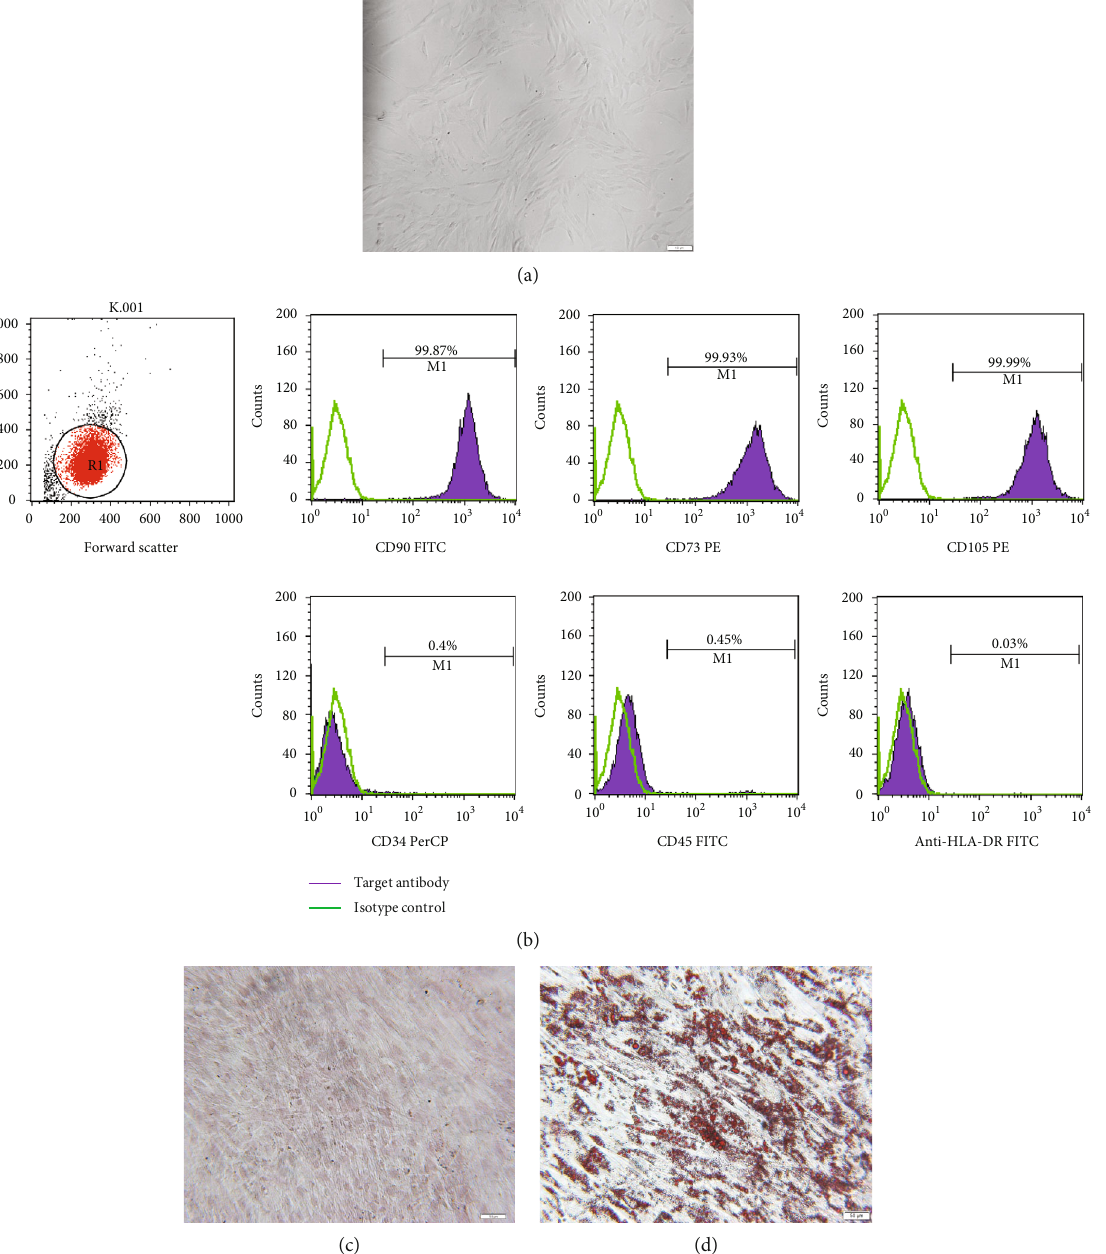
Figure 1: Identi fi cation of human UC-MSCs. (a) Morphological features. The MSCs appeared spindle-like and fi broblastoid-shaped. Scale bar = 100 μ m . (b) Flow cytometric analysis of the expression of cell surface markers related to human UC-MSCs. The expression of each antigen was presented with the corresponding isotype control. (c) Alizarin Red S staining of cultured osteogenic human UC-MSCs. Scale bar = 100 μ m . (d) Oil Red O staining of cultured adipogenic human UC-MSCs. Scale bar = 50 μ m